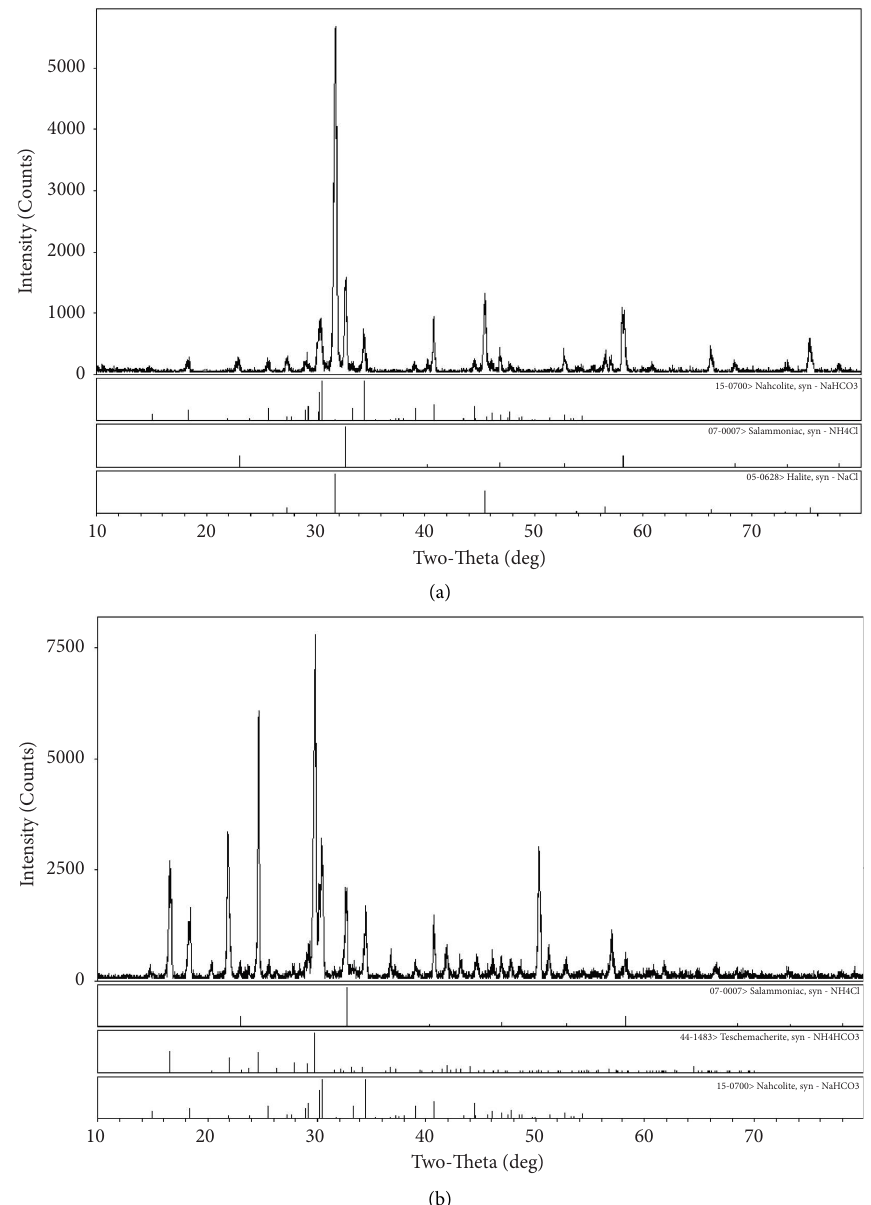
Figure 3: X-ray difraction patterns of solid phases for the invariant points in the systems NaCl+NH NH 4 HCO 3 +NH 4 Cl+ NaHCO 3